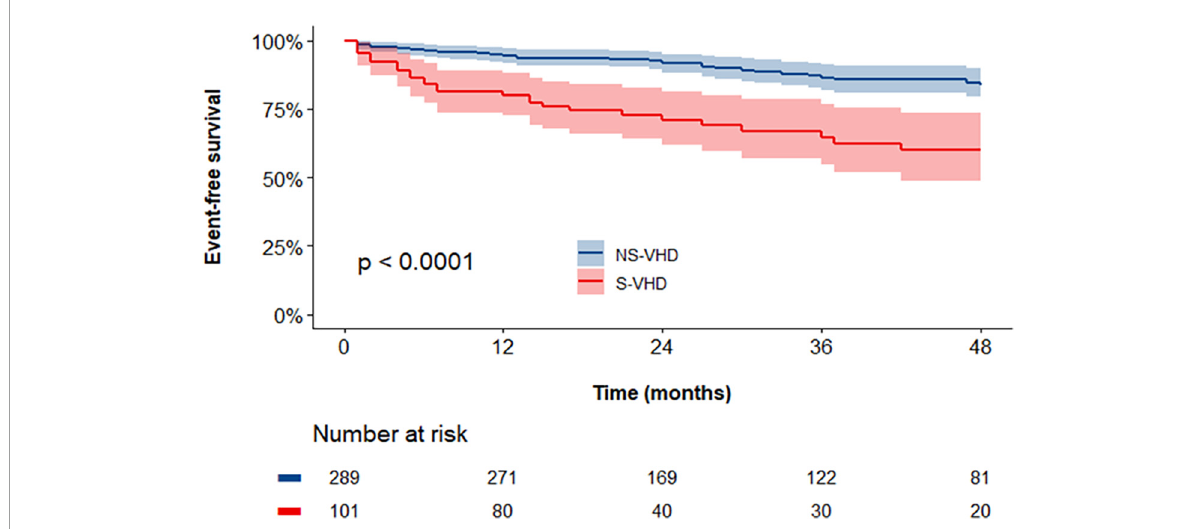
FIGURE3 Kaplan–Meier curves assessing the cumulative event-free survival rates in severe valvular heart disease (S-VHD) and NS-VHD populations. S-VHD, severe valvular heart disease; NS-VHD, non-severe valvular heart